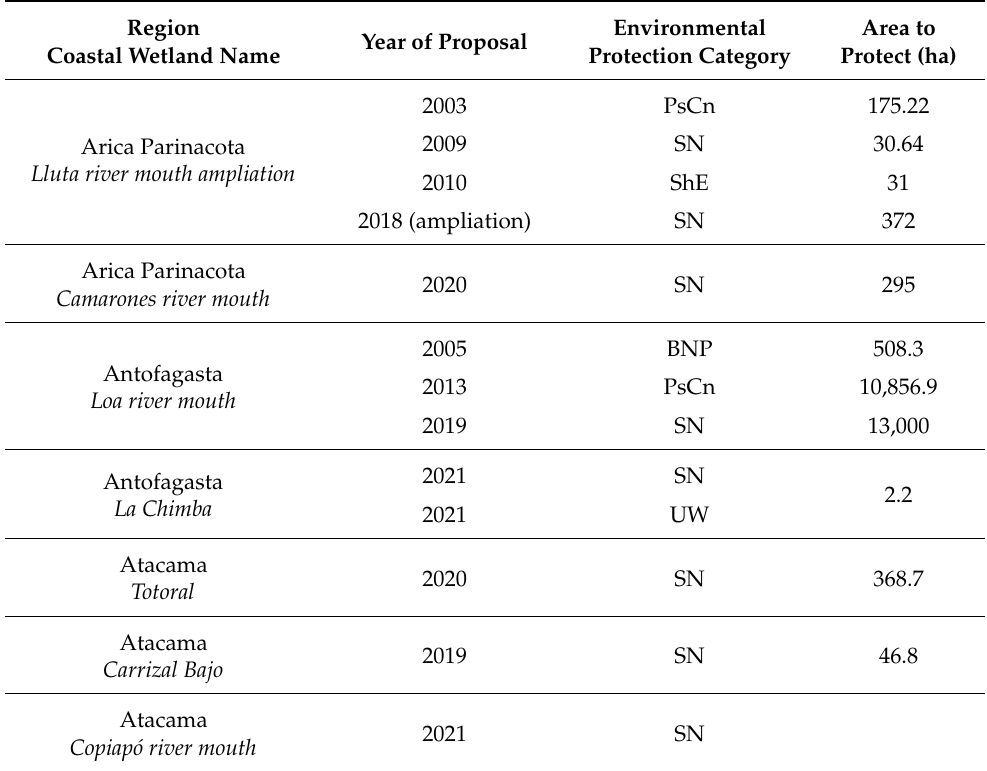
Table 1. Northern coastal wetlands and proposed environmental protection categories (BNP, National Protected Asset; MN, Natural Monument; PsCn Priority Sites for Conservation of Biodiversity; ShE Shorebird Reserve by WHSRN; SN, Nature Sanctuary; UW, Urban